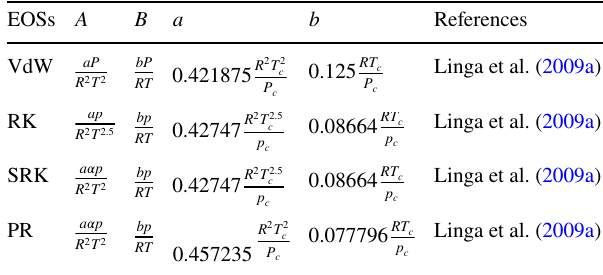
Table 11 VdW, RK, SRK, and PR EOS